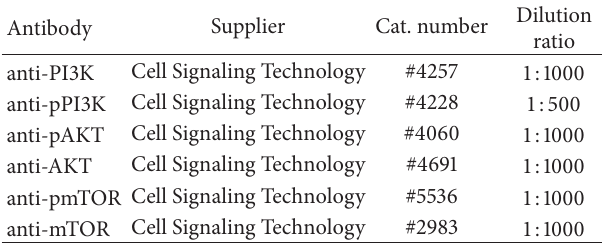
Table 2: Primary antibodies which were used in Western